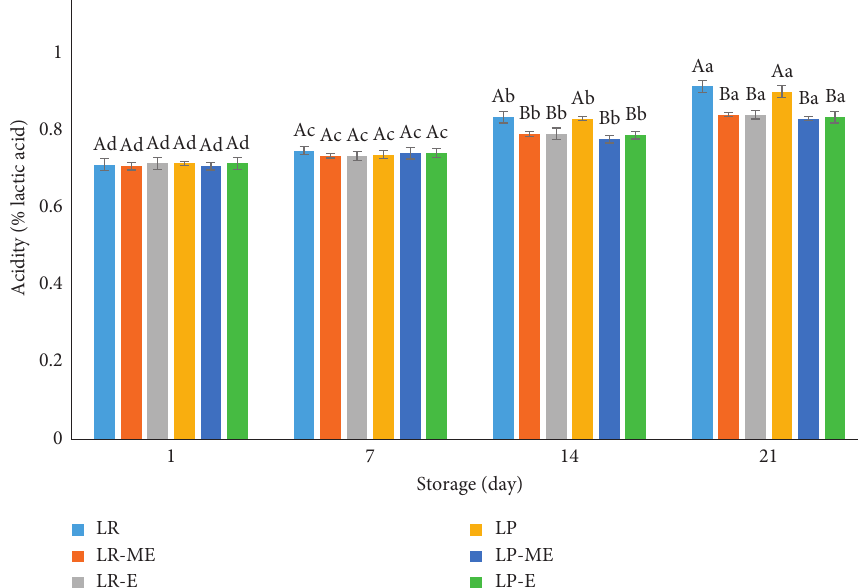
Figure 3: Acidity (% lactic acid) of probiotic yogurt. LR ( L. rhamnosus ), LR-ME (encapsulated L. rhamnosus in multilayer emulsion), LR-E (encapsulated L. rhamnosus in emulsion), LP ( L. plantarum ), LP-ME (encapsulated L. plantarum in multilayer emulsion), and LP-E (encapsulated L. plantarum in emulsion). Capital letters indicate significant differences between samples at the same storage time and different time; lowercase letters indicate significant differences between the same samples at different storage times.